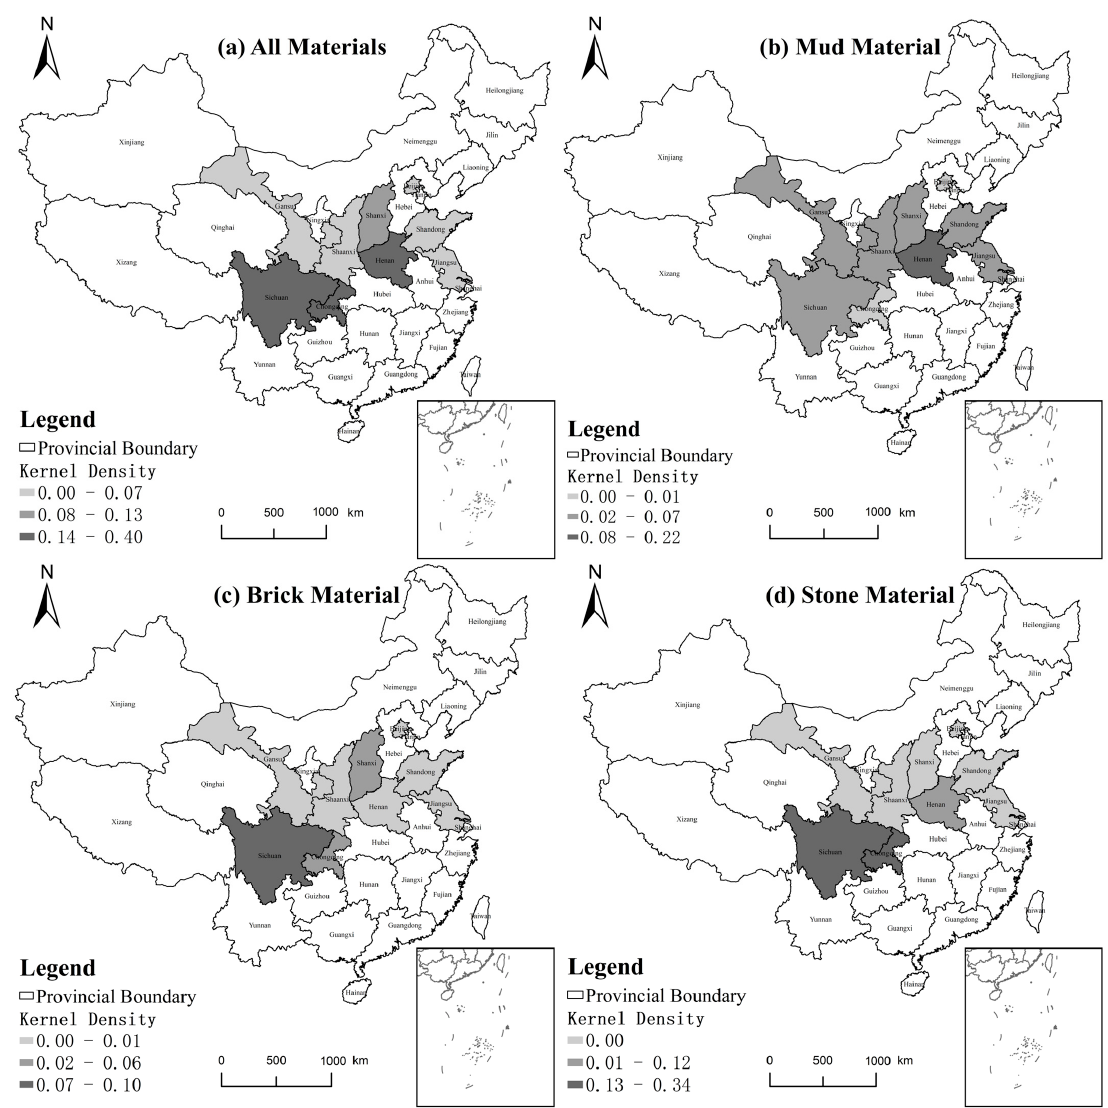
Figure 10. Distribution map of the kernel density of the types of relic sites in the Ming and Qing